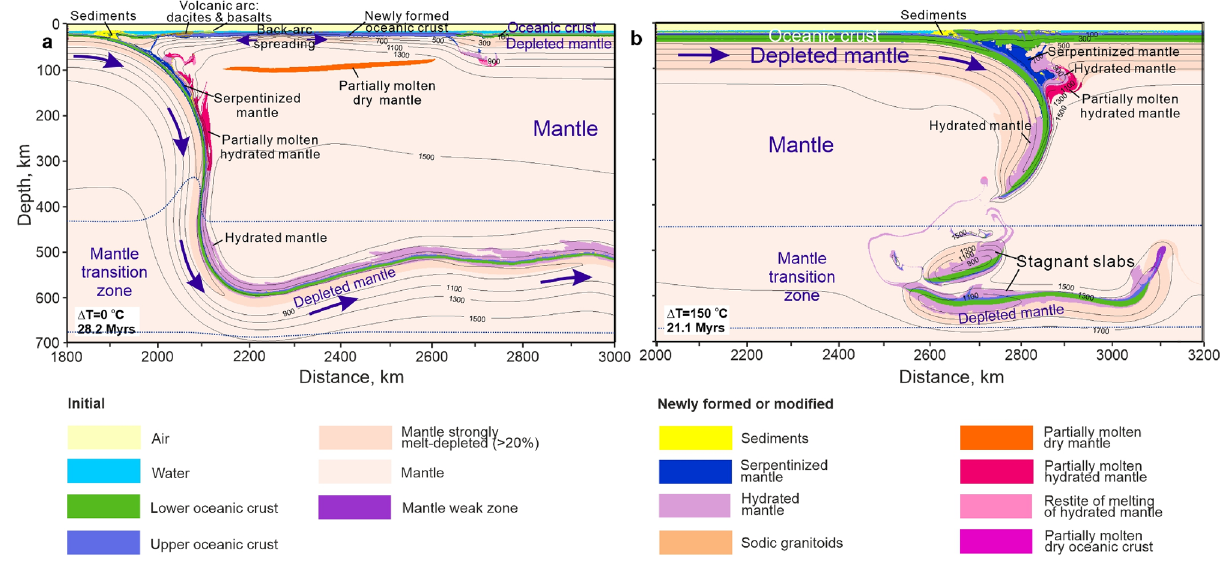
Figure 2. Subduction with relatively thin depleted mantle at constant convergence velocity of 5 cm/year. ( a ) Modern style of subduction with slab retreat and formation of island arcs with basaltic and dacitic volcanism, back-arc basins with a new oceanic crust at modern mantle temperature ΔT = 0 °C (T p = 1300 °C). ( b ) One- sided subduction with voluminous serpentinization in the mantle wedge, dacitic and basaltic volcanism and elevated mantle temperature ΔT = 150 °C (T p = 1450 °C). Dotted dark-blue lines indicate an actual upper and lower boundaries of the initial mantle transition zone. Arrows show direction of plate motion (not to scale) and viscous flow of the depleted mantle. The colour key is shown at the bottom of the figure. Prescribed velocity of the left-hand plate is 5